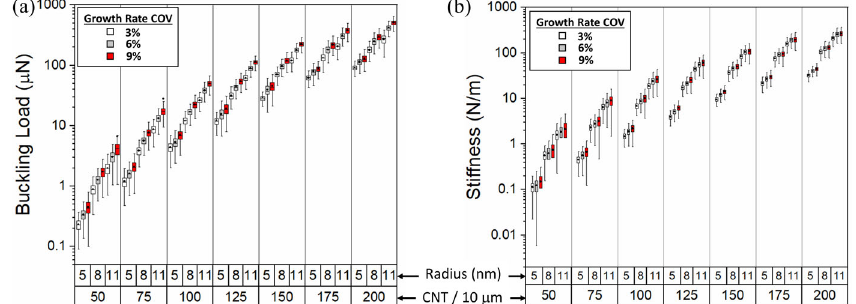
Fig. 4 Nested box plots of simulated CNT forest mechanical properties as a function of class. The ( a ) buckling load and ( b ) elastic stiffness for 63 distinct classes of CNT forests vary by orders of magnitude within the simulated parameter space. The shaded box represents the upper and lower quartile, while the vertical whiskers represent 1.5 times the interquartile range. The bottom grouping, ranging from 50 to 200 represents the quantity of CNTs, the upper grouping represents CNT outer radius of 5, 8, and 11